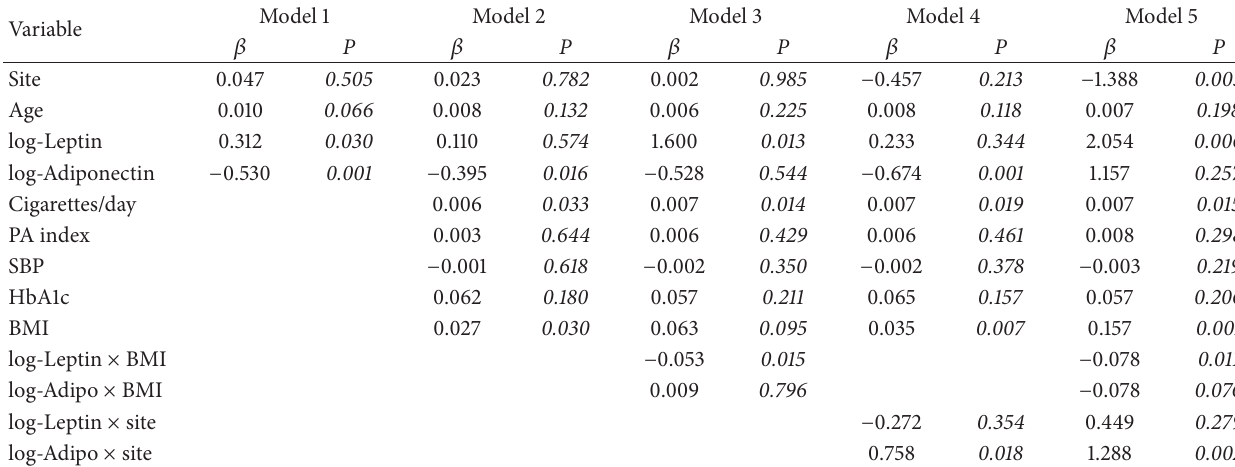
Table 4: Relations of serum log-leptin and log-adiponectin to log-CRP in men.